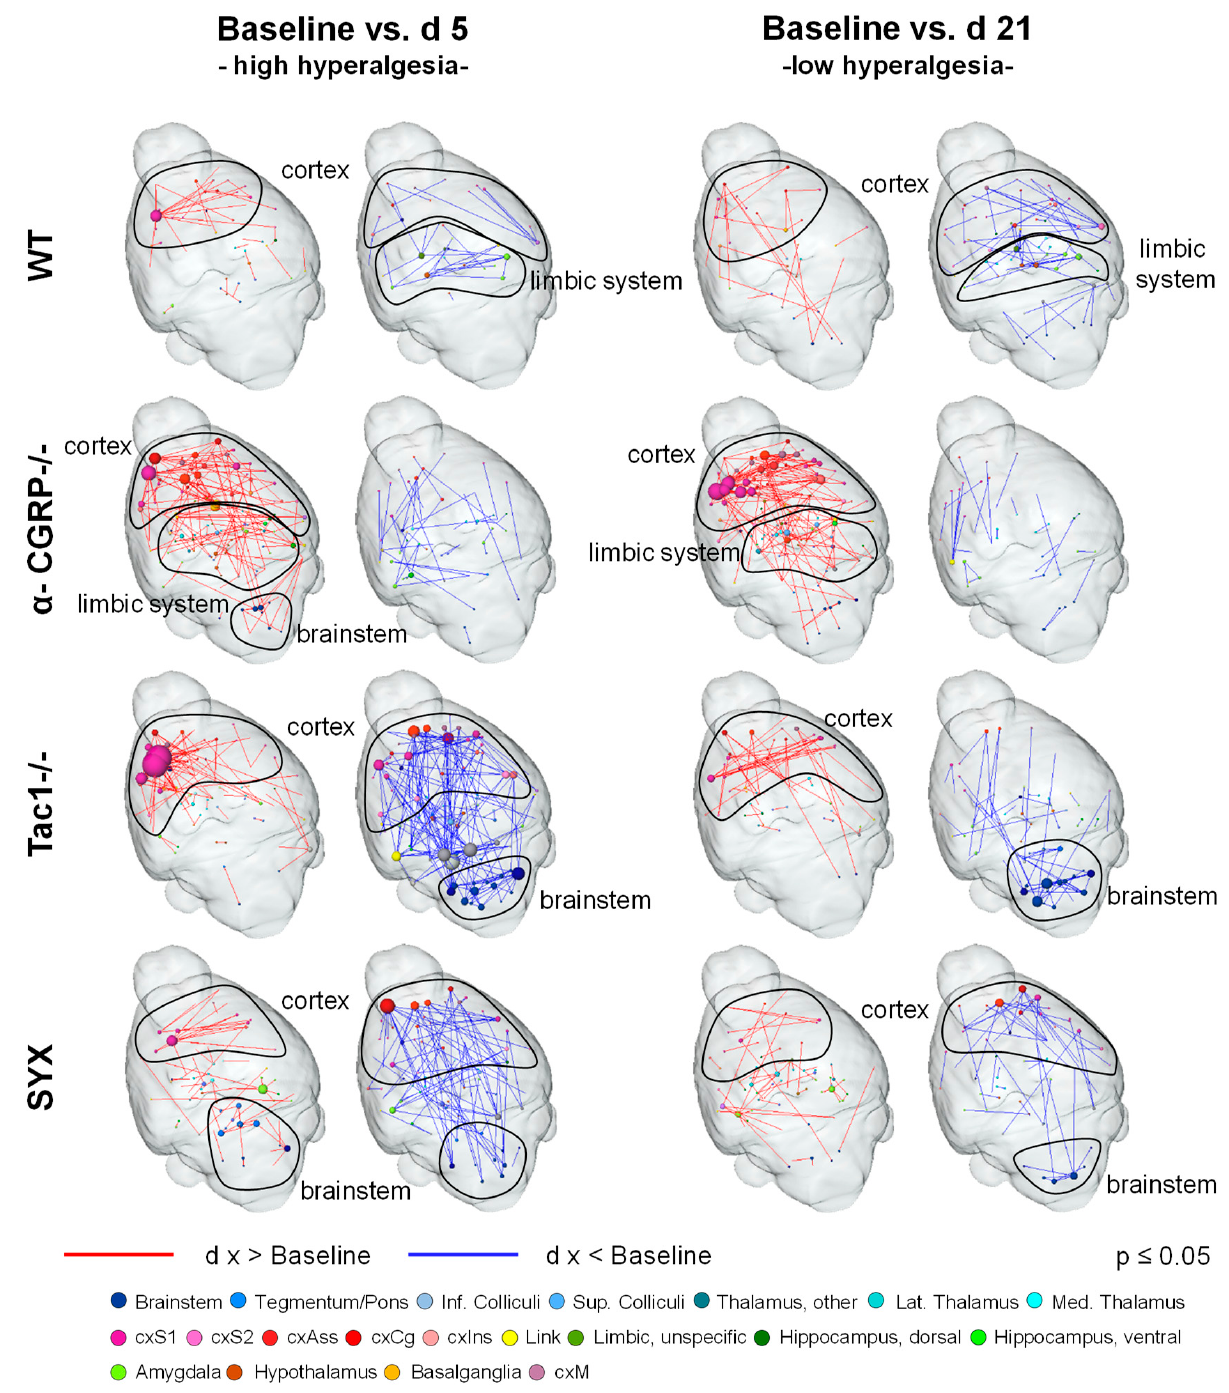
Figure 7. Functional connectivity of cortex and brainstem reflected cerebral hyperalgesia at rest as in vivo marker in resting-state brain networks. Red edges reflect enhanced, blue edges decreased resting-state functional connectivity (RS FC) at day 5 or day 21 after fracture, respectively, compared to baseline. Color-coded nodes represent the different brain regions, with the size of the nodes reflecting the degree, i.e., how many connections this node has to others unconnected nodes are omitted. Abbreviations: cxS1 (primary somatosensory cortex), cxS2 (secondary somatosensory cortex), cxAss (association cortex), cxCg (cingulate cortex), cxIns (insular cortex), cxM (motor cortex), inf. (inferior), lat. (lateral), med. (medial), sup. (superior). (nWT = 13, nCGRP − / − = 9, nTac1 − / − = 9, nSYX = 8).